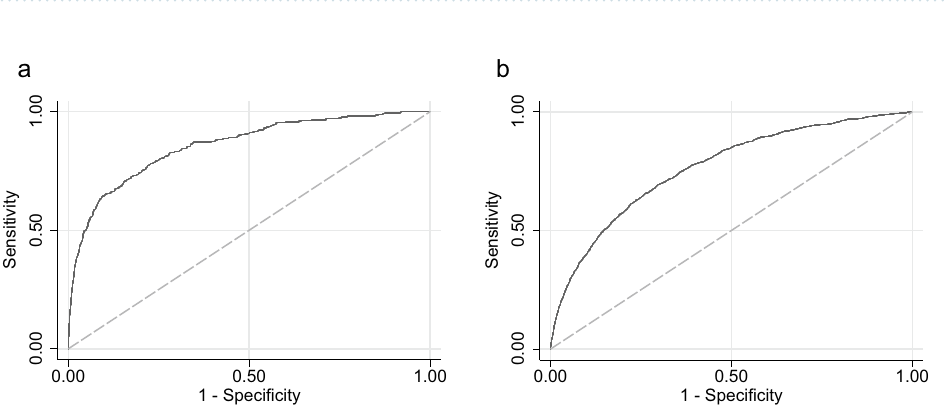
Table 3. Performance of the predictive models for preeclampsia, preeclampsia with delivery < 37 weeks and preeclampsia with delivery ≥ 37 weeks at different gestational ages in the in the study population of 58 899 nulliparous women. *Diagnosis of preeclampsia at any gestational length with delivery ≥ 37 weeks. † The model is composed of the predictive variables collected at first antenatal visit, the time-varying predictors plasma glucose and proteinuria, and the u-scores of level, trend and curvature for each of the time-varying predictors systolic and diastolic blood pressure, haemoglobin, maternal weigh and symphysis fundal height up until the gestational week of prediction (24, 28, 32, 34 and 36). ‡ AUC: Area under receiver operating characteristic curve. § FPR: False positive rate.